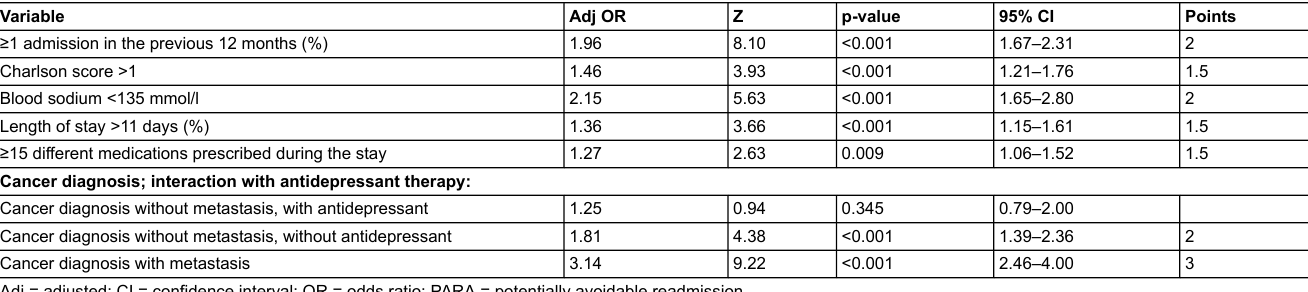
Table 3: Variables from the multivariate model predicting PARA 30 days after discharge in the included population.